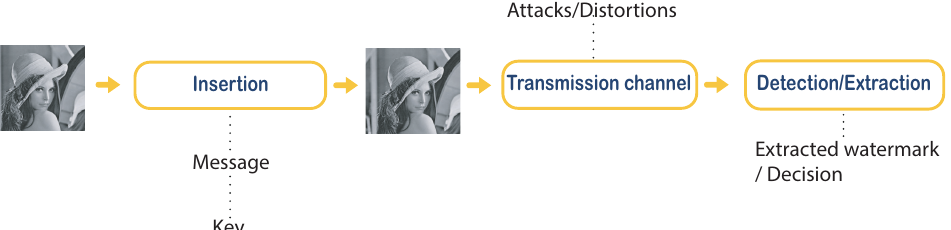
Figure 4. General scheme of digital